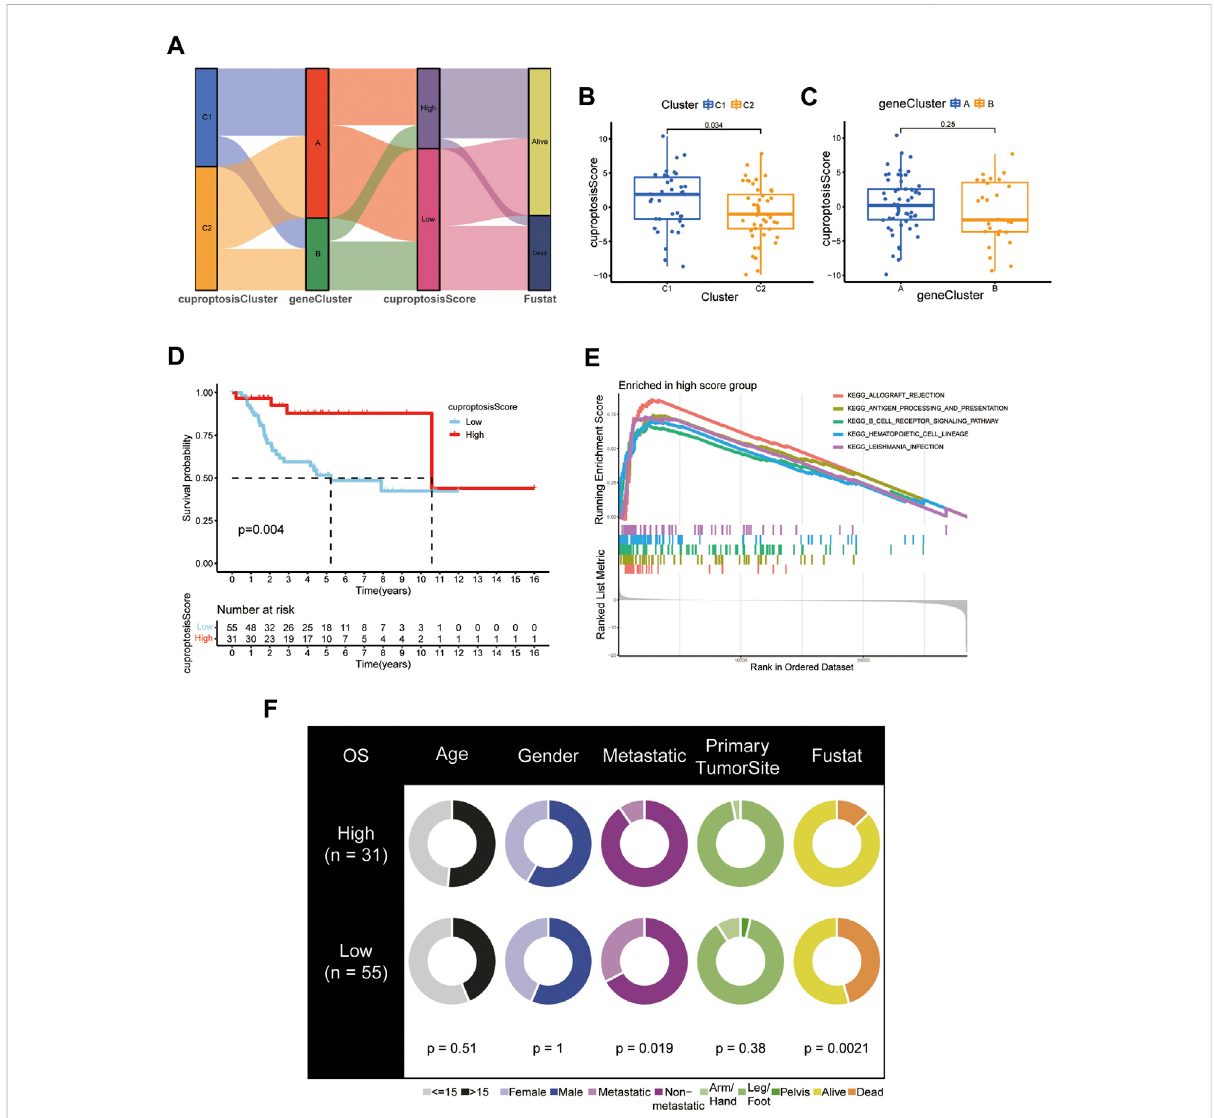
FIGURE 8 Development and validation of the cuproptosis scoring system for OS. (A) Sankey Diagram of cuproptosis clusters, gene clusters, cuproptosis score, and clinical outcomes. Differences in cuproptosis score between (B) the two cuproptosis subtypes and (C) the two gene clusters. (D) Kaplan- Meier analysis ofthe OS betweenthe two cuproptosisscore groups. (E) GSEA showed the differentpathwayssigni fi cantly enriched inthe high score group. (F) Clinical characteristics for the high and low cuproptosis score groups. ( p < 0.05 *; p < 0.01 **; p < 0.001